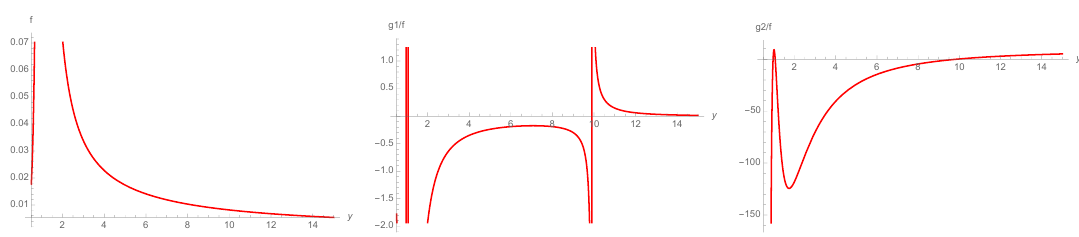
Figure 1 . A representative solution with g = 1 / 4 , b = − 0 . 1 , and C = 1 . The solution is regular in the range of y = 9 . 897 < y < ∞ 1